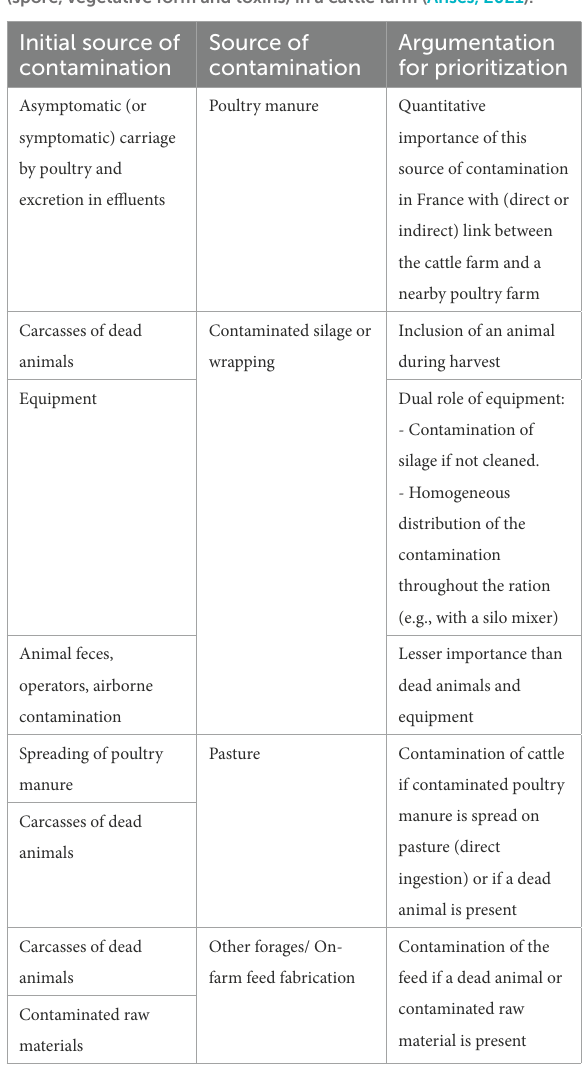
TABLE 6 Prioritization of importance (decreasing order) of the different initial sources and vehicles of C. botulinum contamination (spore, vegetative form and toxins) in a cattle farm (Anses,